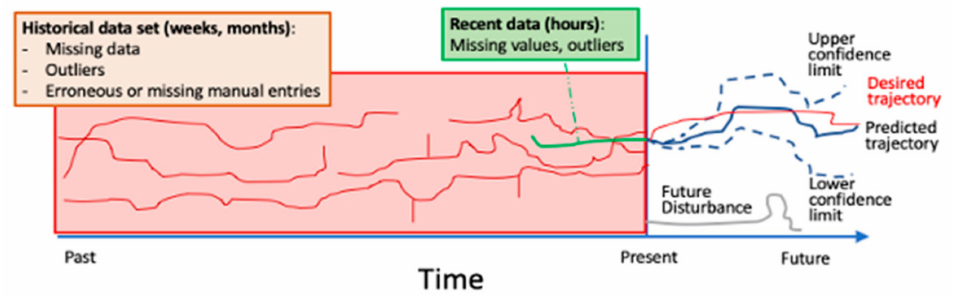
Figure 7. Lengths of historical data to capture many behavior patterns of a person (red), recent past data for use by MPC (green) and challenges in data missing values, outliers). Confidence limits in the prediction of future BGC, and disturbance